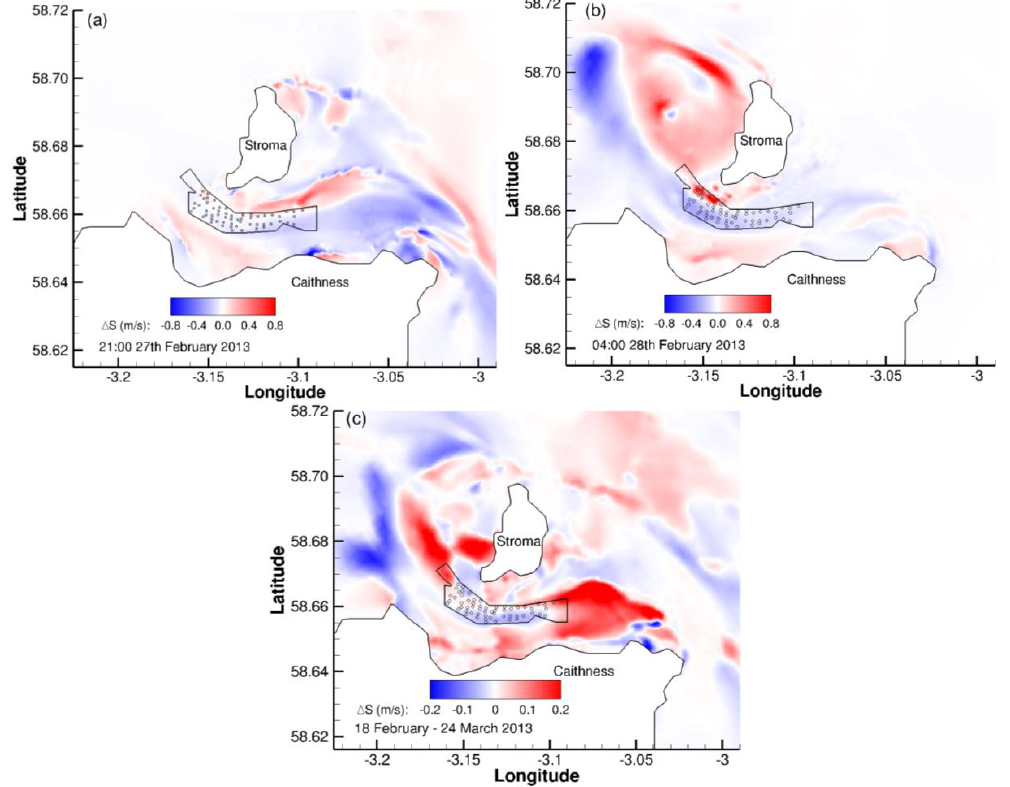
Figure 8. The modelled effect of 57 turbines on near-bed current speed (Δ S , m·s −1 ) at ( a ) spring tide flood; and ( b ) spring tide ebb, in the Inner Sound on 27–28 February 2013. Δ S is the difference in bed stress between the simulations with no turbines (Run 1) and with 57 turbines (Run 7). Positive values indicate an increase in current speed with turbines; negative values indicate that the speed is reduced with the turbines in place. The difference in the maximum current speed that occurs at each model location over the whole simulation (i.e., not necessarily contemporaneously) between the two simulations is also shown ( c ). Tidal turbine locations (o) and the lease area (―) are indicated. On the ebb tide, the changes in current speed are even more marked. Again, flow within the array is reduced and that reduction extends several kilometers downstream, and there is an area of increased flow along the northern perimeter of the array lease area. Most noticeably, however, is the large area in the lee of Stroma where the turbine array appears to increase the ebb current speed. This occurs because of a small shift in the position of the ebb tide jet emerging from the western end of the Inner Sound, which strengthens the gyre circulation in the lee of Stroma.